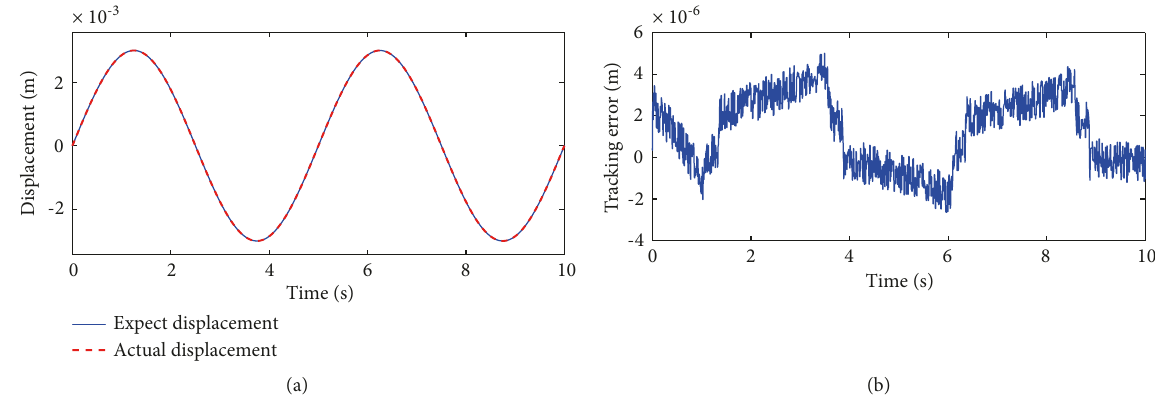
Figure 9: Sinusoidal response curve of adaptive friction compensation control. (a) Sinusoidal input response curve of the table. (b) Table sinusoidal input tracking error curve.